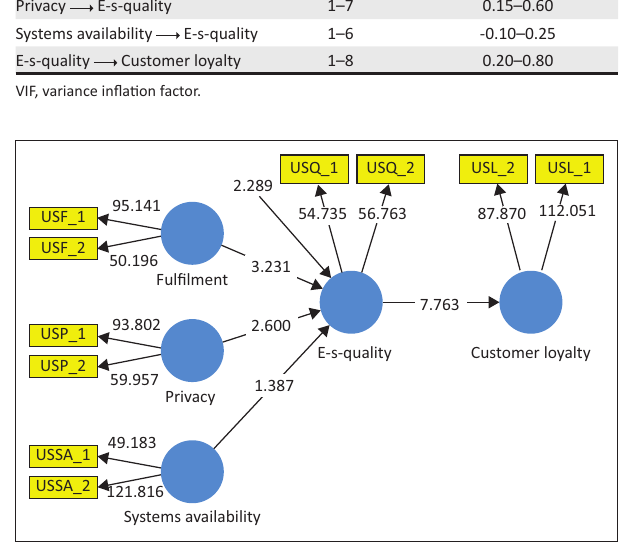
FIGURE 4: Partial least squares structural equation modelling path model for Unstructured Supplementary Service Data banking.